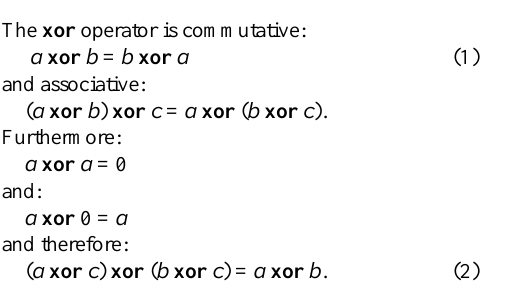
Fig. 2: Bitwise Exclusive OR, left: on a single bit, right: on two arbitrary 8-bit